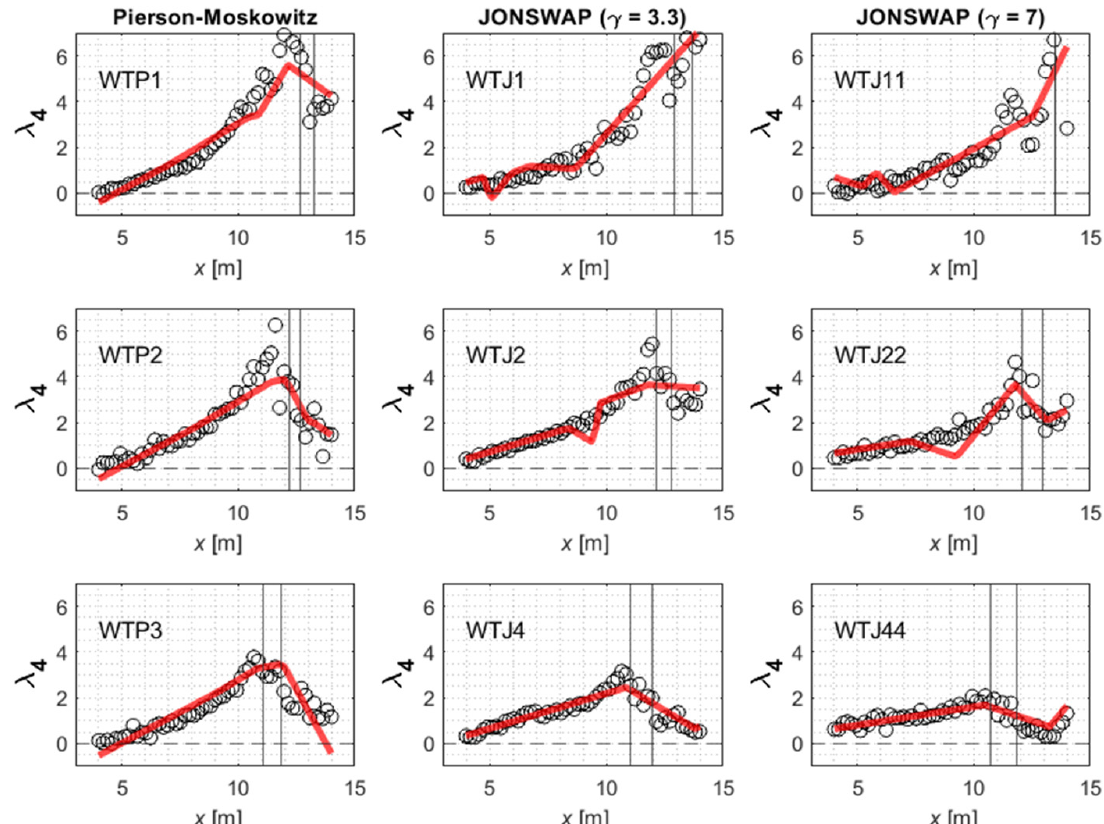
Figure 10. Experimental (open circles) versus predicted (red continuous line) values of kurtosis.